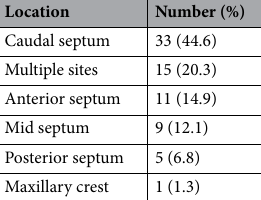
Table 2. Locations of persistent septal deviation.